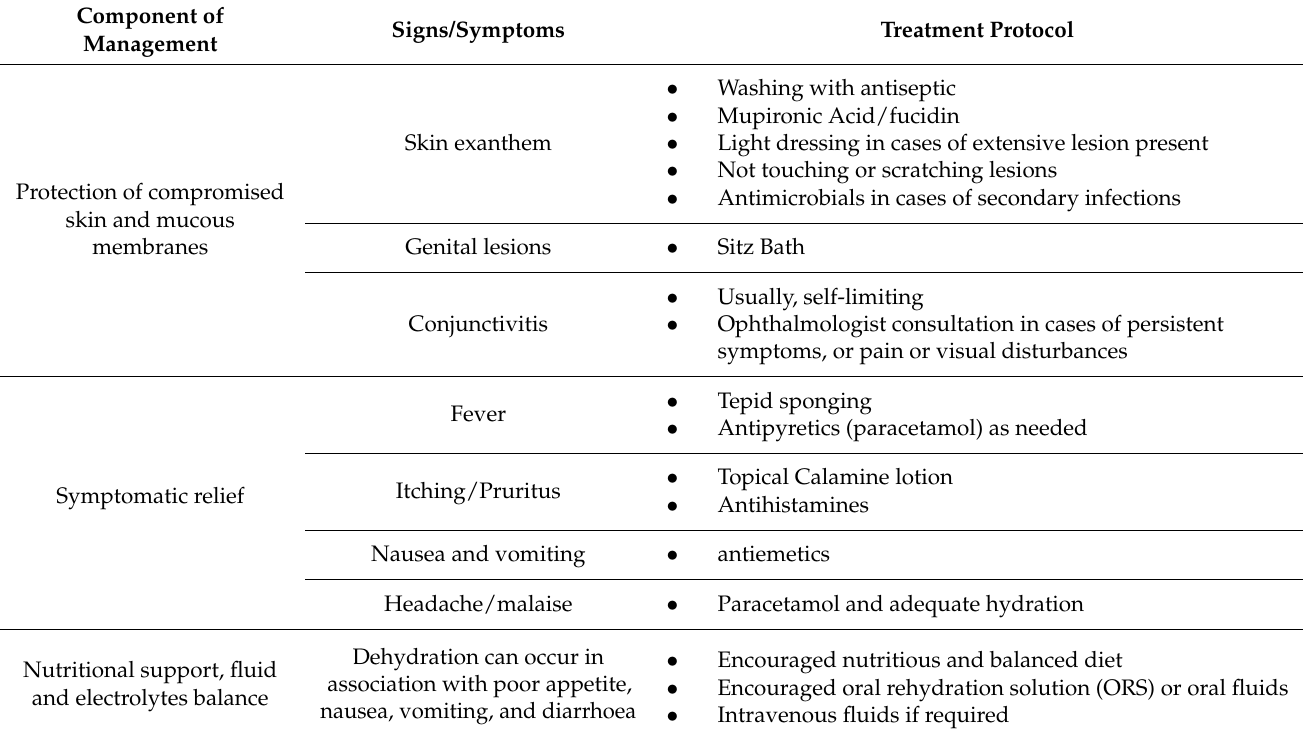
Table 3. Symptomatic and supportive treatment for